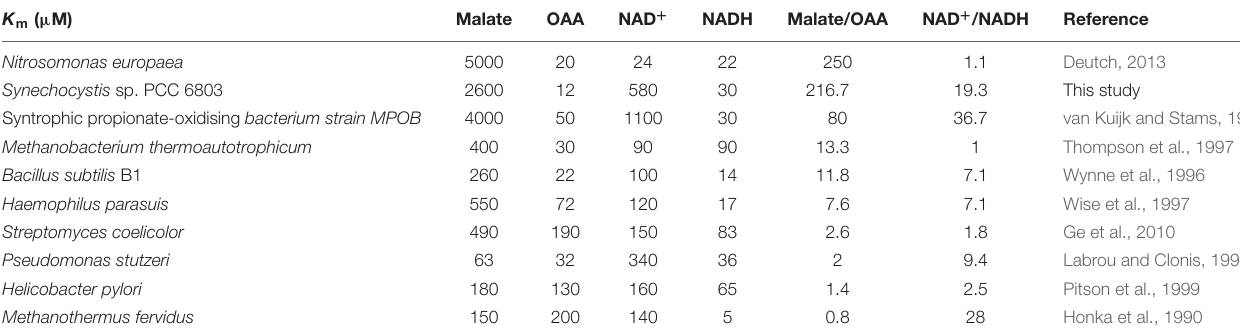
TABLE 2 | Comparison of K m -values of MDHs in various microorganisms. K m ( µ